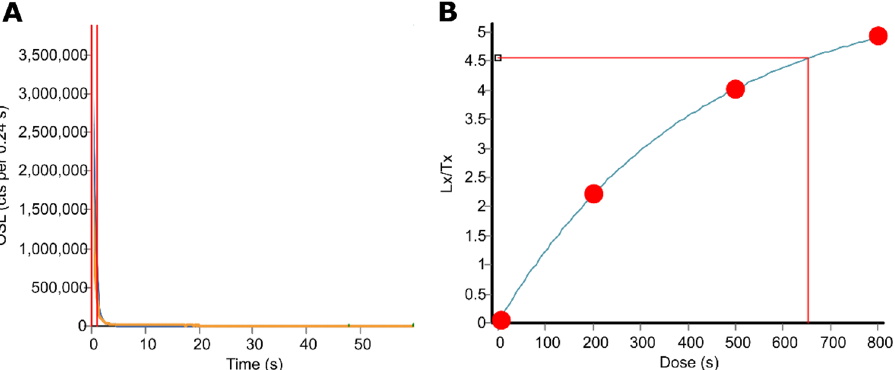
Figure 3. Examples of OSL measurements from Shfd16117. ( A ) A shine down curve showing rapid decay of the OSL signal with stimulation indicative of a signal dominated by the fast component. ( B ) A Single Aliquot